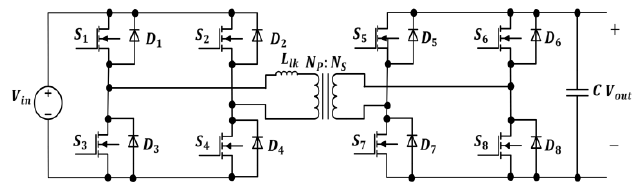
Figure 1. DAB converter circuit diagram.